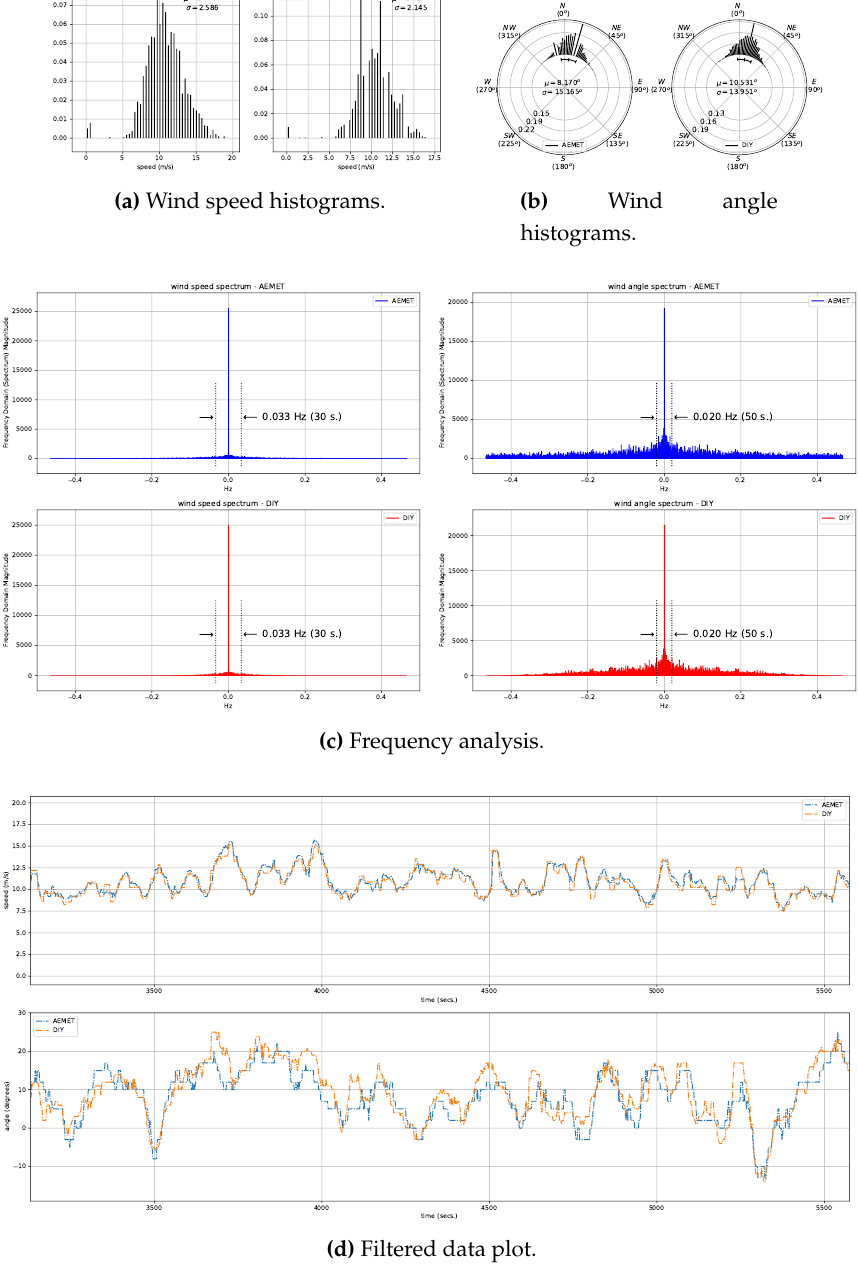
Figure 7. Data validation. ( a , b ) show respectively the normalized histograms for raw wind speed and direction angle data acquired by each sensor. Each histogram line represents the fraction of measurements in a discrete interval or bin of speeds and angles, respectively. Histogram bins are evenly spaced and have the same width; ( c ) shows the frequency analysis of collected raw wind speed and direction angle data, and the low-pass filter threshold applied; ( d ) shows a plot of the filtered data. In all figures, AEMET refers to AEMET’s sensors, and DIY to one of the wind sensing devices which make up our DIY data acquisition